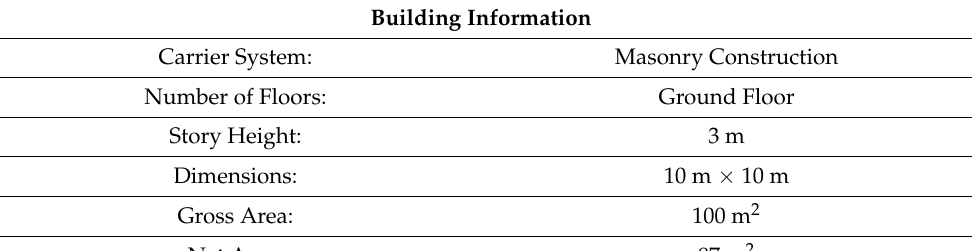
Table 4. The building information of the analyzed structure.